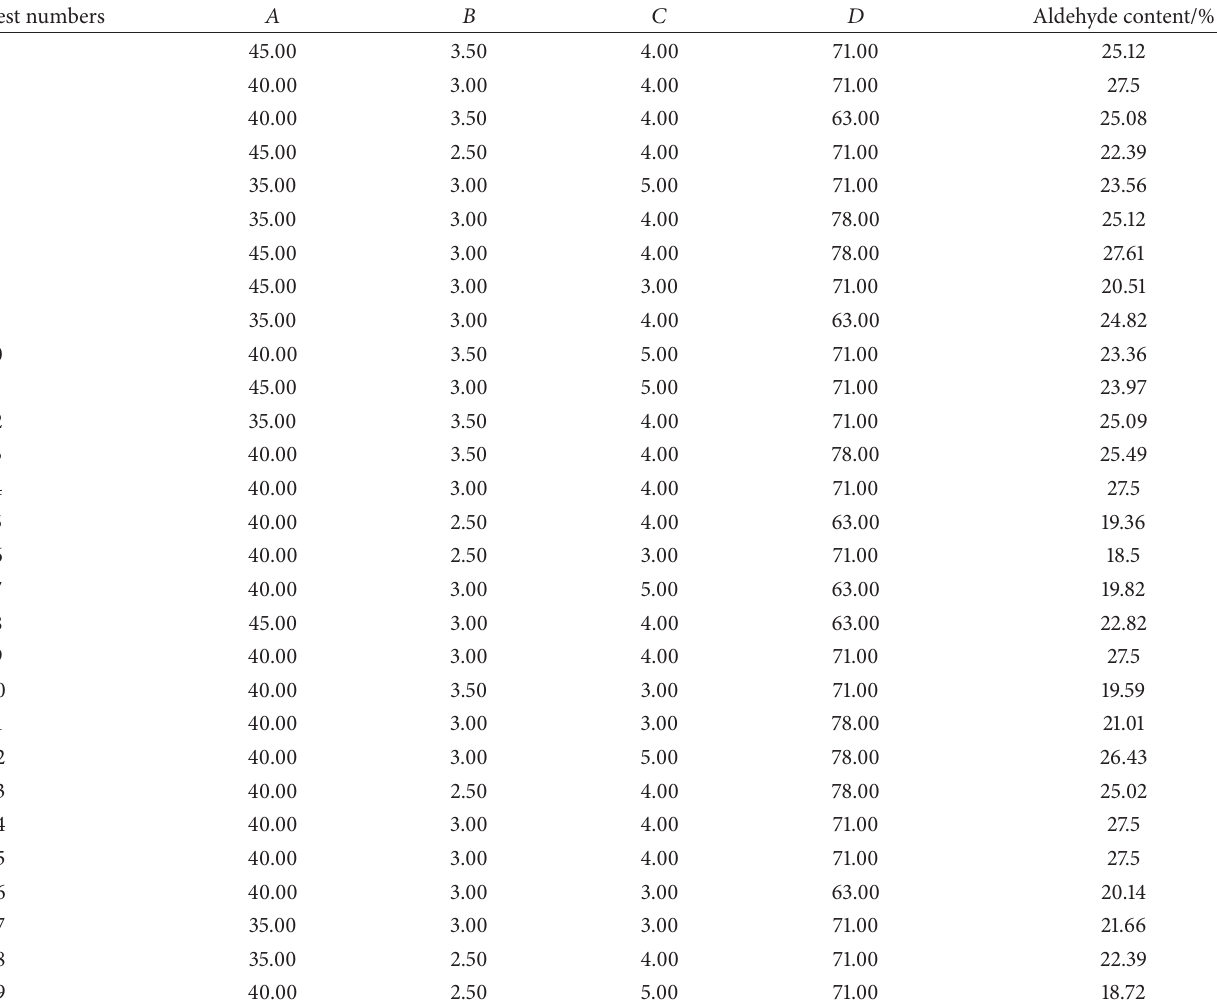
Table 2: Design and results of response surface test for